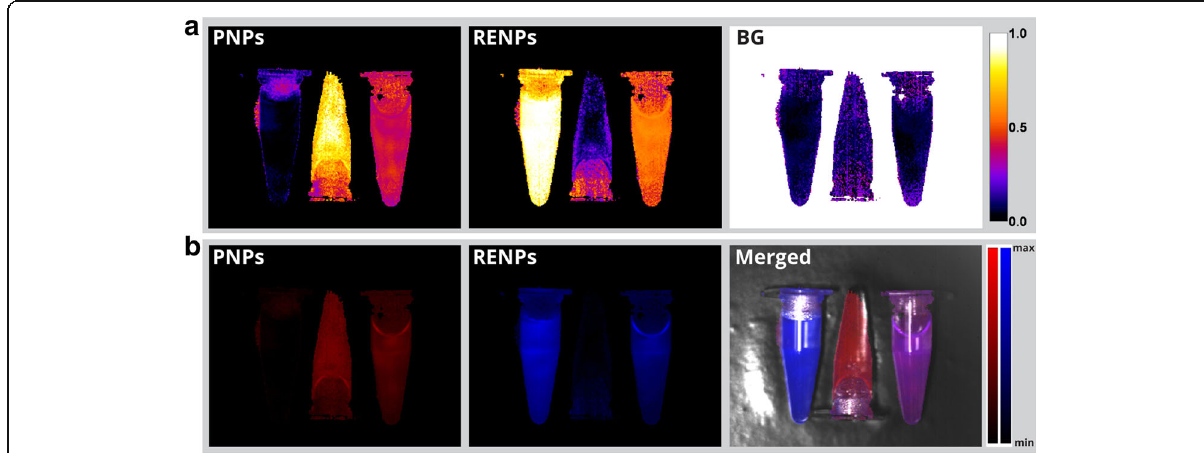
Fig. 5 HSI of microcentrifuge tubes containing (left to right) RENPs, PNPs, and mixture of both. a Abundances of PNPs, RENPs, and background